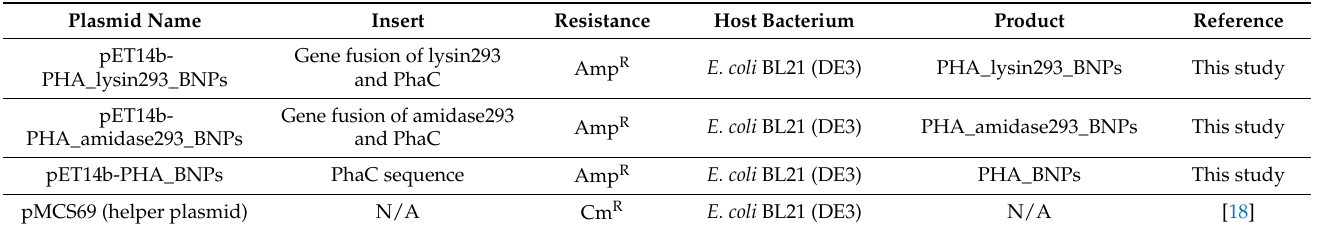
Table 1. Plasmids used in this study, detailing insert, features, host and